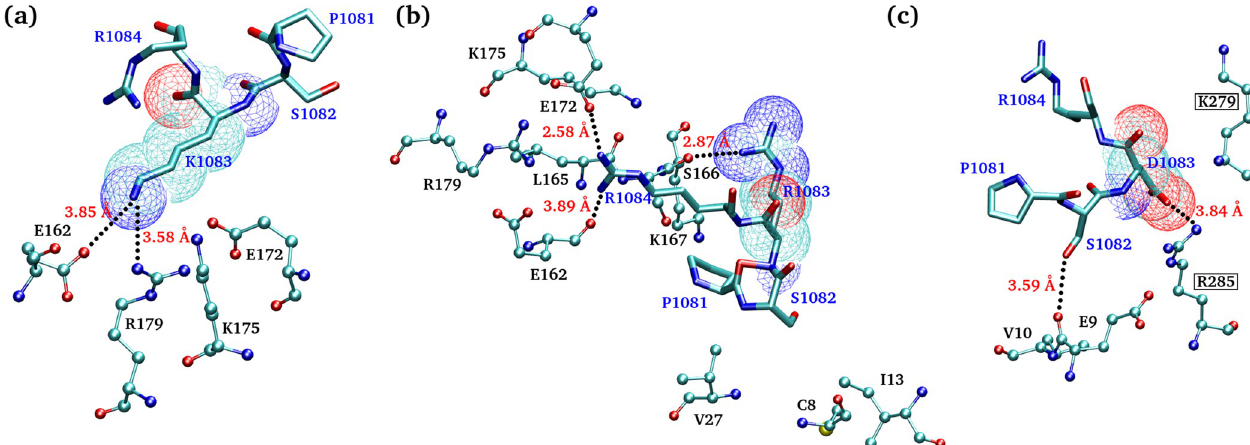
Fig 7. Interacting residues of Cyc-D1/CDK4 complex within 5 Å of Rbl2 residues P1081, S1082, X1083 and R1084 are shown for (a) Wild-type, (b) K1083R and (c) K1083D ligands. The residues of Cyc-D1/CDK4 are in CPK model and labeled in black while the residues of Rbl2 are drawn as licorice with blue labeled. Hydrogen bonds have been displayed in black dotted lines with corresponding distances in red. Oxygen, nitrogen and carbon atoms are represented by red, blue and cyan colors, respectively.